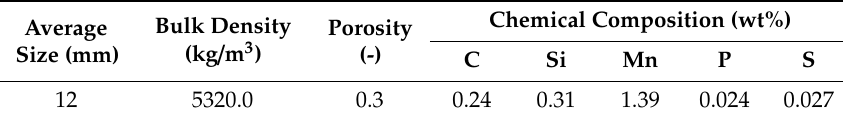
Table 2. Properties of scrap.